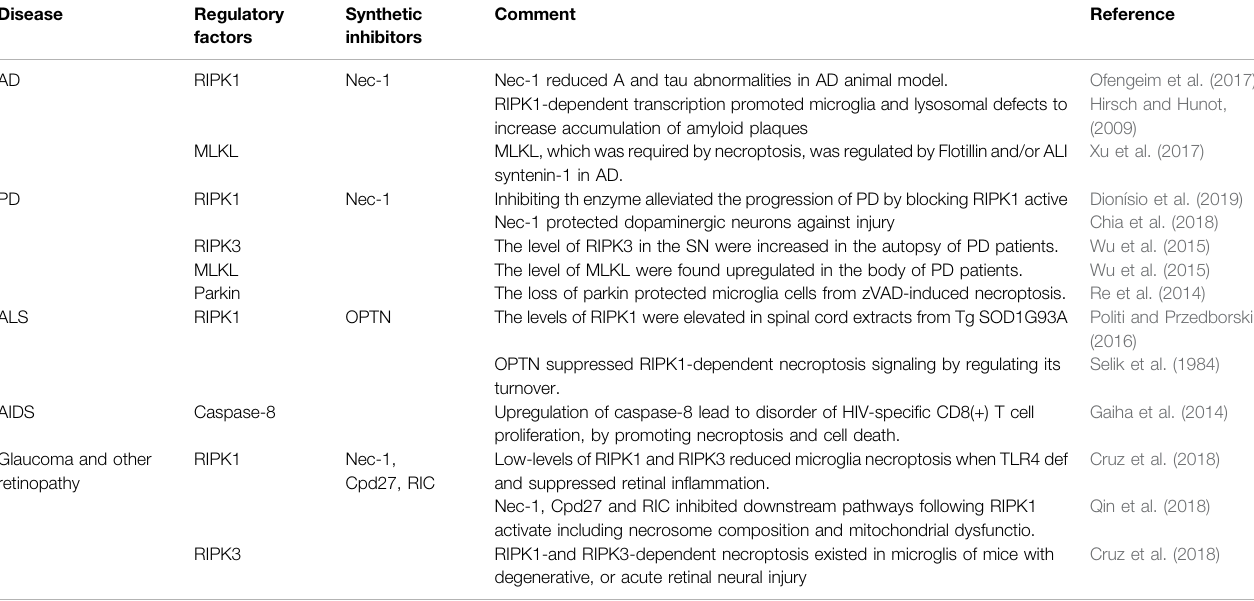
TABLE 2 | Necroptosis in chronic neurodegenerative diseases.